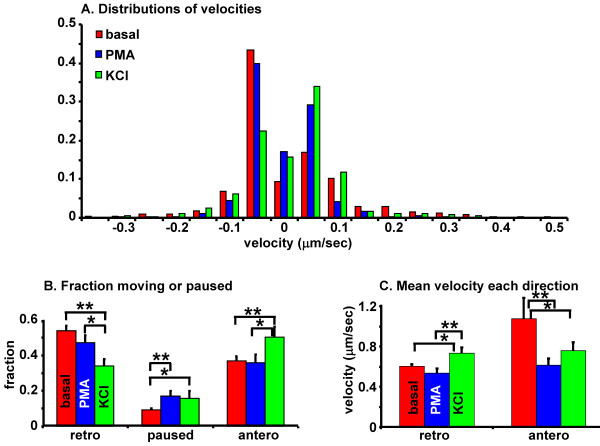
Secretagogues differentially affect instantaneous velocity and direction. Instantaneous velocity and direction were calculated for tracked LDCVs in neurons kept under basal conditions or exposed to PMA or KCl for 5 min. LDCVs moving in the retrograde direction were assigned a negative sign, and those moving in the anterograde direction received a positive sign (A); the distribution of binned data is shown for representative cells from each treatment group. The fraction of LDCVs stopped or moving in a given direction (B) is plotted as an average; the relationship between direction and velocity was also analyzed (C). One-way ANOVA with Bonferroni post-test (SPSS package): *, p < 0.02; **, p < 0.01.